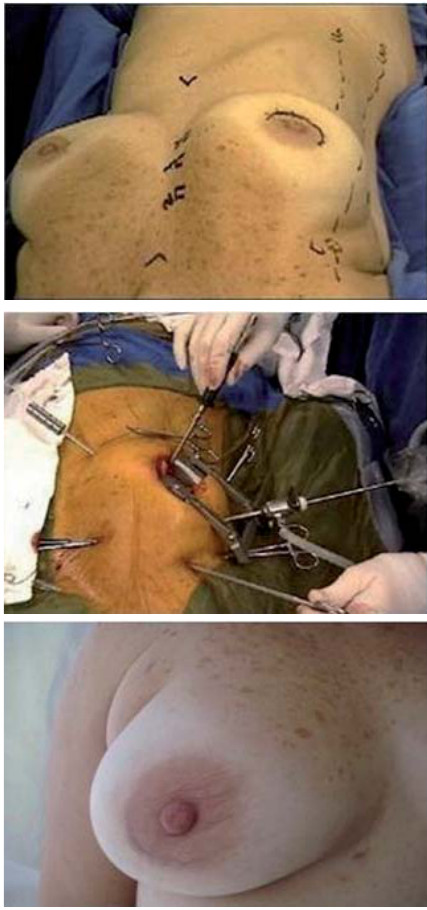
Fig. 2 - Acesso periareolar videoassistido: aspecto do campo operatório e